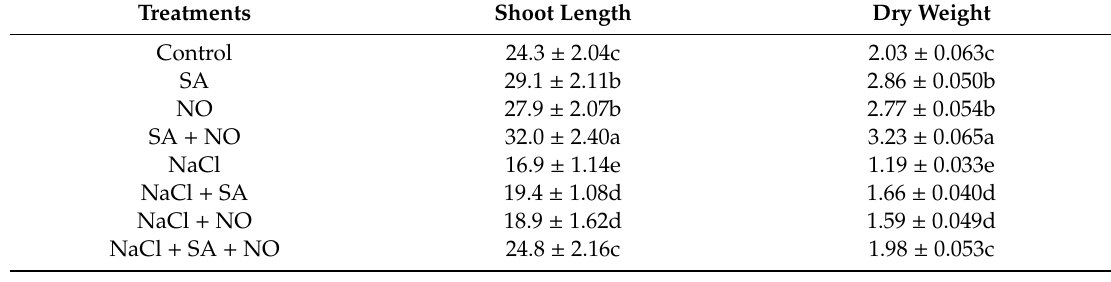
Table 1. E ff ect of exogenous application of salicylic acid (SA) and nitric oxide (NO) on shoot length (cm) and plant dry weight (g / plant) in Vigna angularis under salinity (100 mM NaCl) stress. Data are the mean of four replicates and di ff erent letters show a significant di ff erence at p < 0.05. Treatments